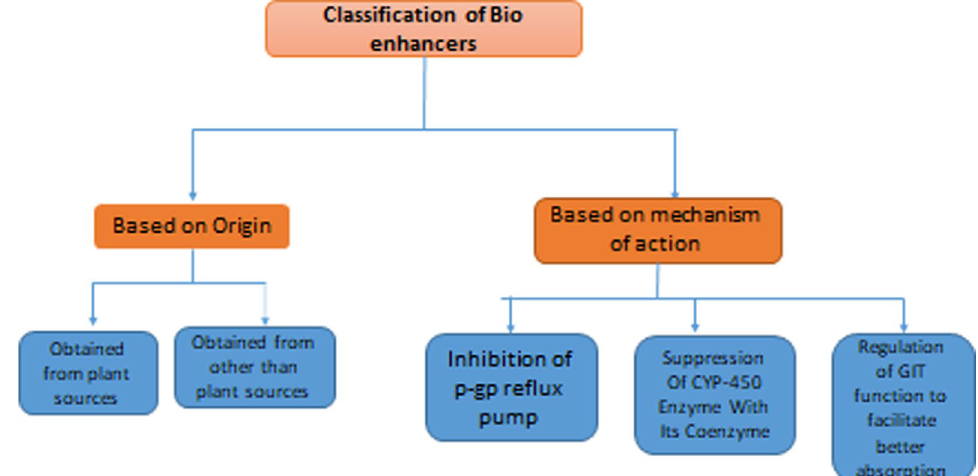
Table 4—Transferosome Formulation, Table